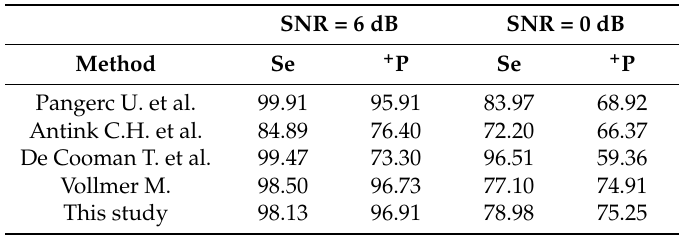
Table 1. Se and + P values obtained using the MIT-BIH Noise Stress Test Database, with a SNR = 6 dB and 0 dB.